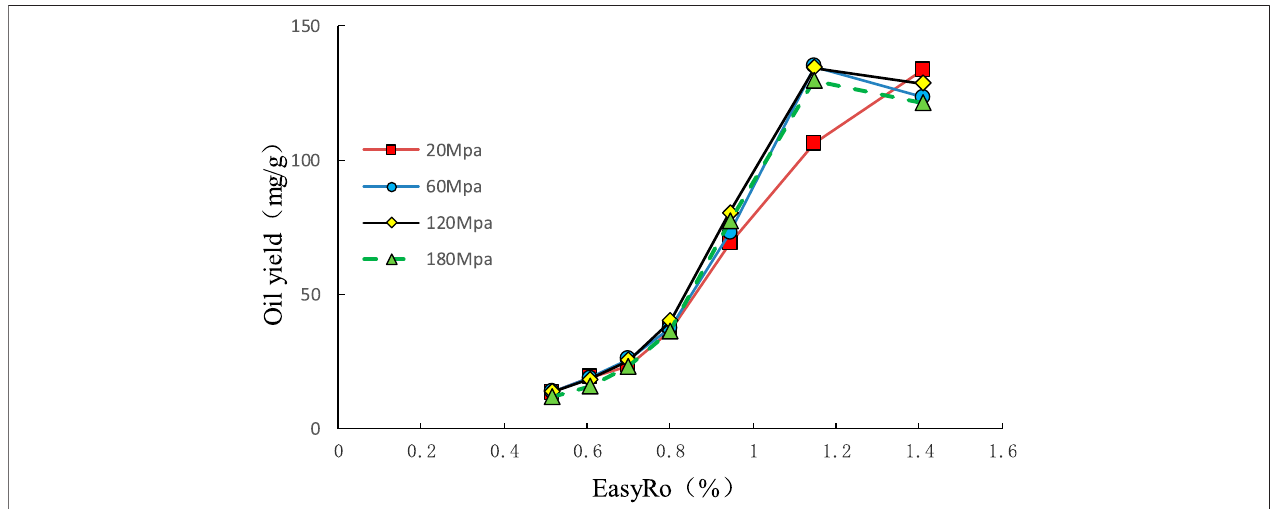
FIGURE 9 | Comparison of phased oil yields of sample 2,911 under different pressure conditions.